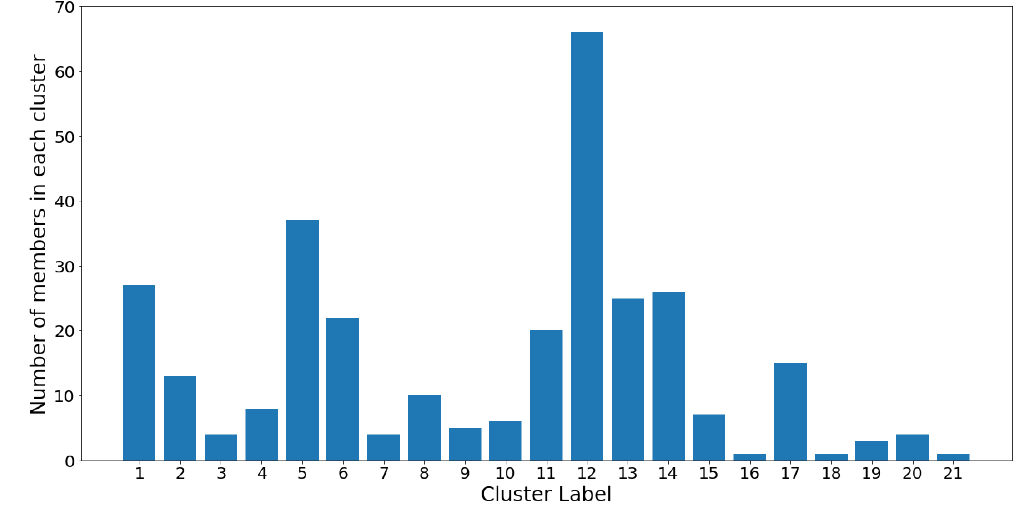
Figure 16. Populations for the AIC-optimal GMM model with K = 21